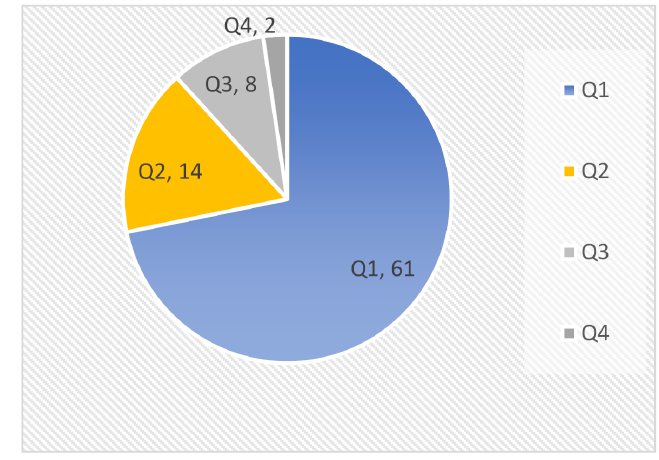
Figure 4. Number of Qualitative articles in